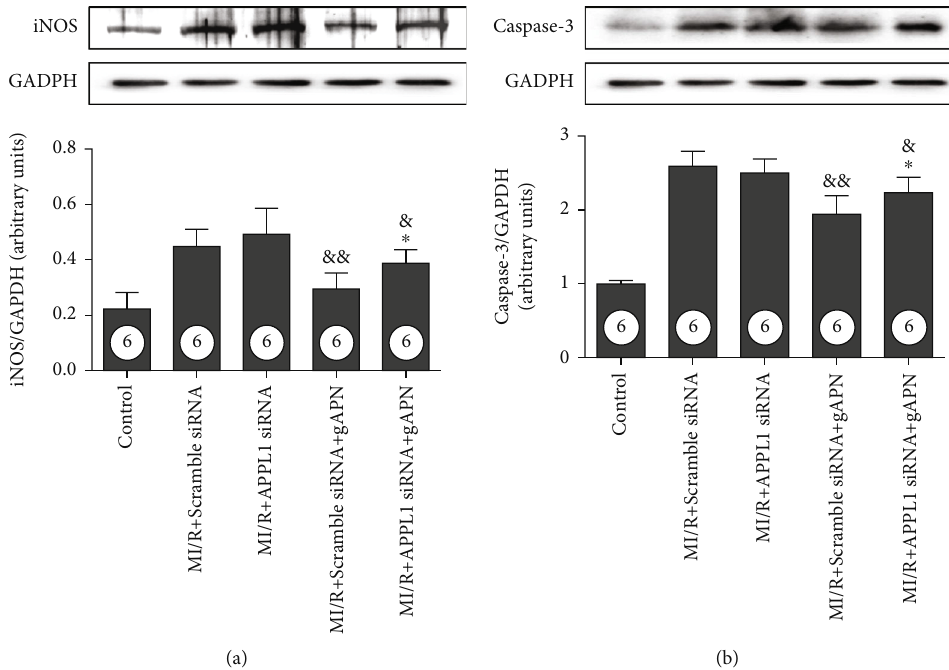
Figure 5: Cardiac speci fi c injection of APPL1 stealth RNAi blunted antinitrative and antiapoptotic e ff ects of APN. (a) iNOS expression by representative Western blots. (b) Caspase-3 expression by representative Western blots. ∗ P < 0 : 05 vs. the same treatment group without APPL1 siRNA. & P < 0 : 05 ; && P < 0 : 01 vs. the same treatment group without